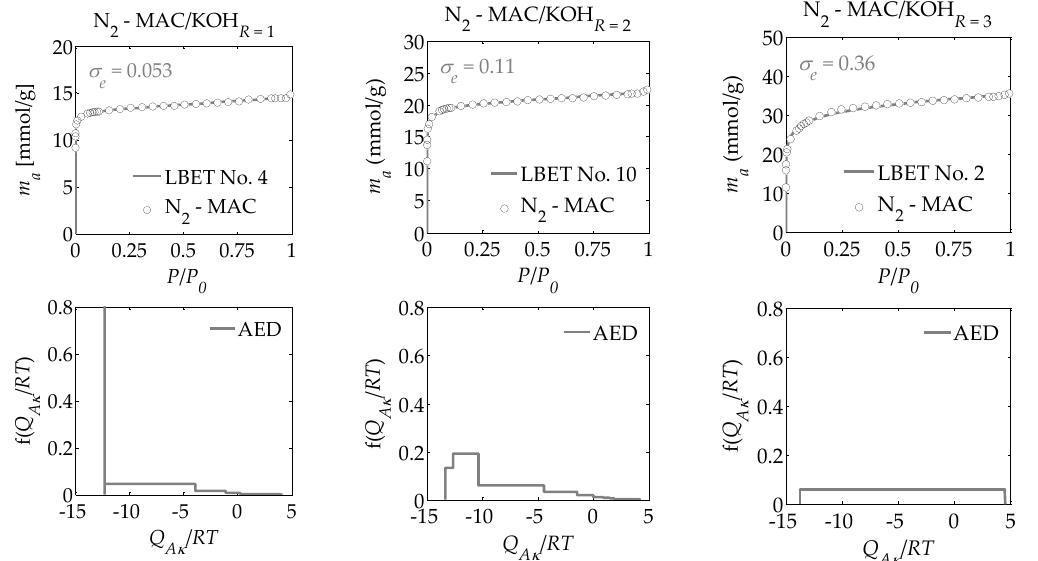
Figure 1. Nitrogen adsorption isotherms for the activated carbons MAC prepared from mahogany wood using KOH as an activator at a varying ratio R of the activator to the product of carbonized wood mass and the fast multivariate identification procedure results obtained using the LBET method, as well as the adsorption energy distributions in the first adsorption layer.